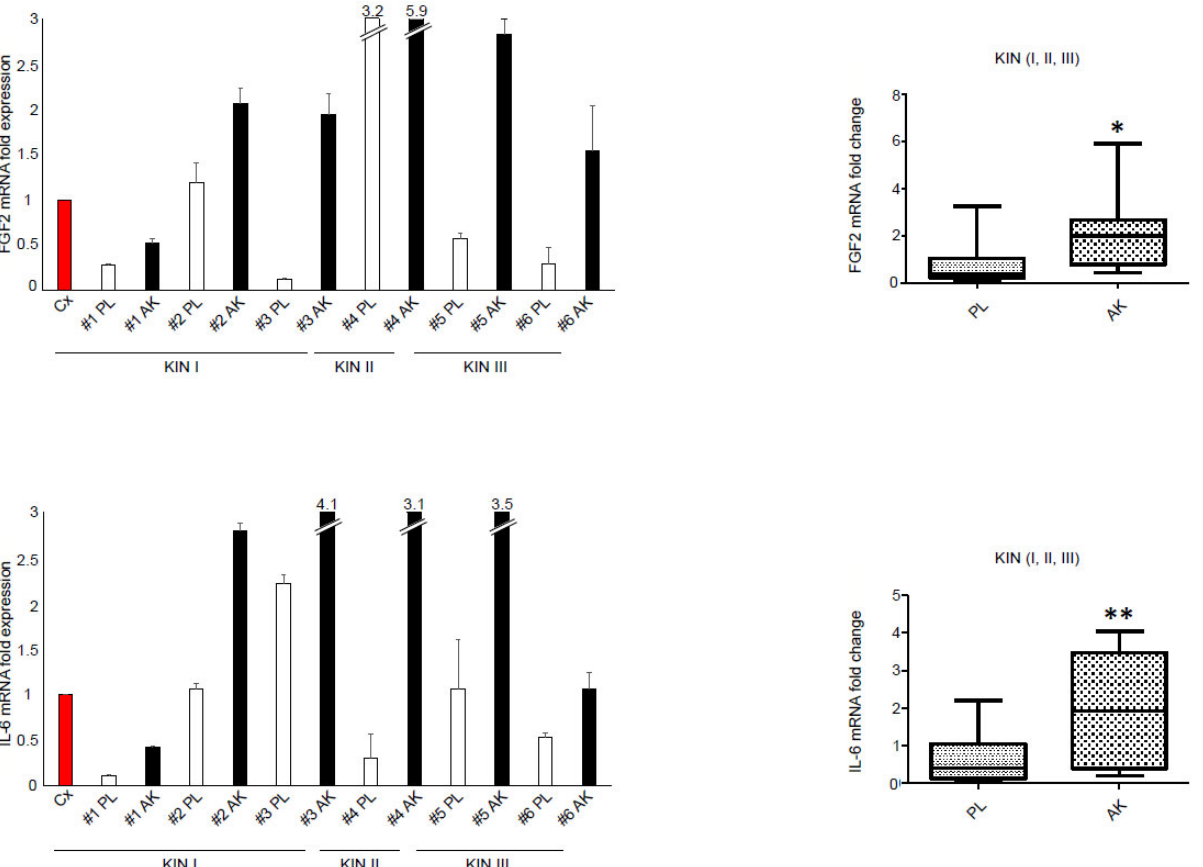
Figure 4. Expression of cancer-promoting factors in the dermal portion of KIN I, KIN II, and KIN III samples. FGF2, IL-6 mRNA levels were evaluated by real-time RT-PCR in KIN I, KIN II, and KIN III samples (PL—perilesional samples, white bars; AK—lesional samples, black bars) and normalized in respect to the mean of all the perilesional values (Cx, red bar), as reported in the graph. Results are expressed as mean ± SD. Statistical analysis of relative expression rates of KIN I + KIN II + KIN III AK versus KIN + KIN I + KIN III PL samples was performed using Wilcoxon rank-sum test, and significance levels were defined as p < 0.05: * p < 0.05; ** p < 0.01 versus the corresponding PL samples.